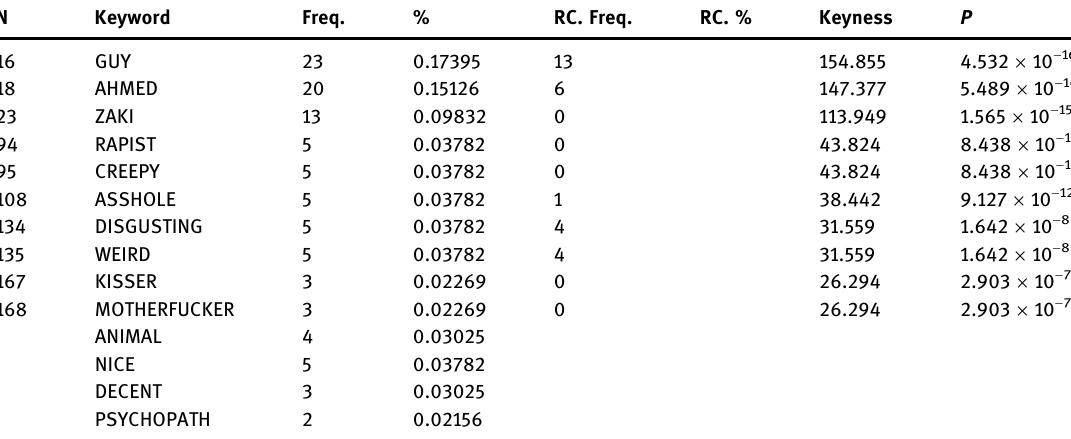
Table 8: Keywords used for naming and describing ABZ